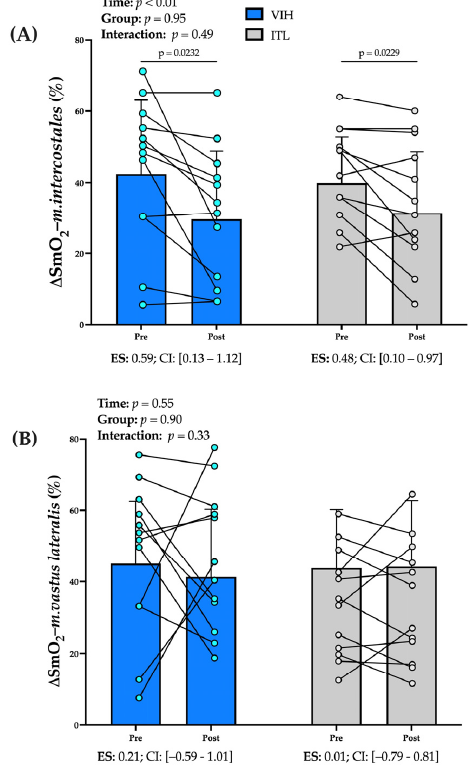
Figure 2. Comparison on changes in desoxygenation ( Δ SmO 2 ) of ( A ) intercostales muscles ( Δ SmO 2- m.intercostales , %), and ( B ) vastus lateralis muscles ( Δ SmO 2- m. vastus lateralis , %). Data were shown in mean ± SD. The factors (time and group) and their interaction are shown (group × time). Effect size (ES) are shown with confidence interval (CI) at 95%.